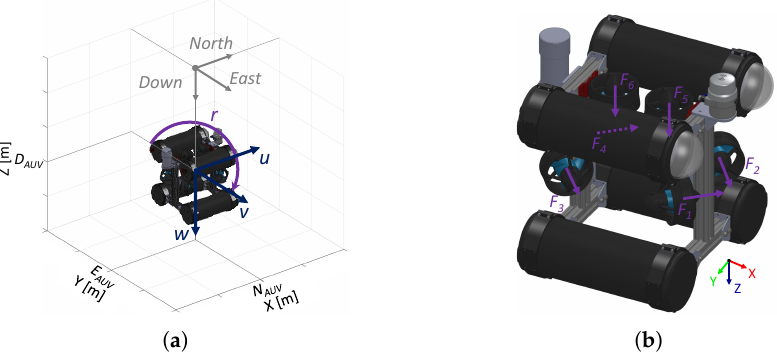
Figure 6. Six-thruster configuration in the AUV: ( a ) Simplified model of the considered vehicle using the NED coordinate system. ( b ) Thrust forces with their direction for each